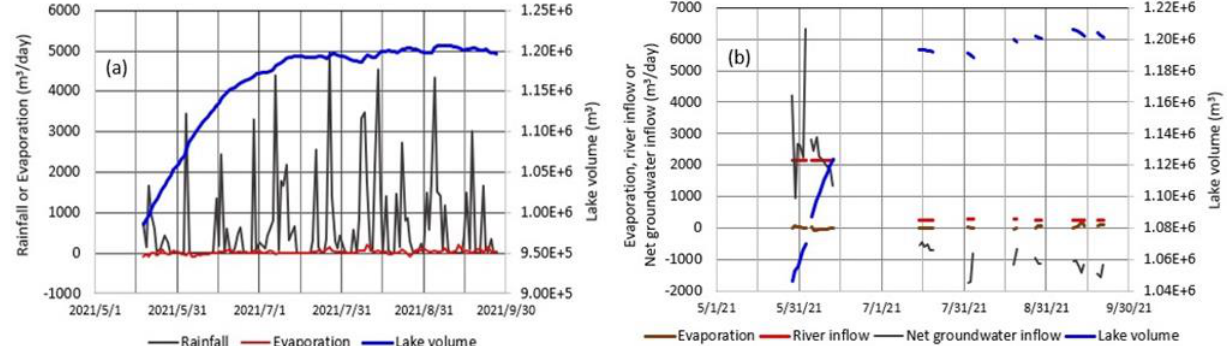
Figure 17. Temporal variations in ( a ) daily mean lake volume, diurnal total evaporation E·A 0 , and diurnal total rainfall P·A 0 in May – September 2021 (Figure 12), and ( b ) calculated diurnal net groundwater inflow, observed diurnal river inflow, the total evaporation E·A 0, and daily mean lake volume in the non-rainfall periods.